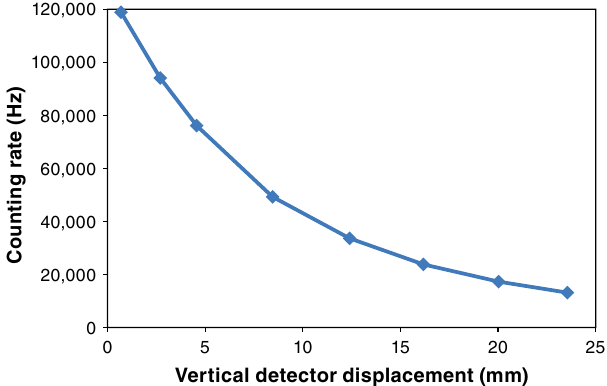
FIG. 12. Counting rate as a function of the vertical displace- ment of the eBSD detector. These results were obtained with a 100 GeV = nucleon 3 He beam consisting of 93 bunches with 4 . 7 × 10 10 ions per bunch and a 6 keV, 88 mA electron beam. The zero of the displacement scale corresponds approximately to the center of the detector being 5 mm above the center of the electron beam. The operating point was the rightmost point on the chart, at 24 mm. The counting-rate slope at that point is approximately 6 . 8 % = mm.